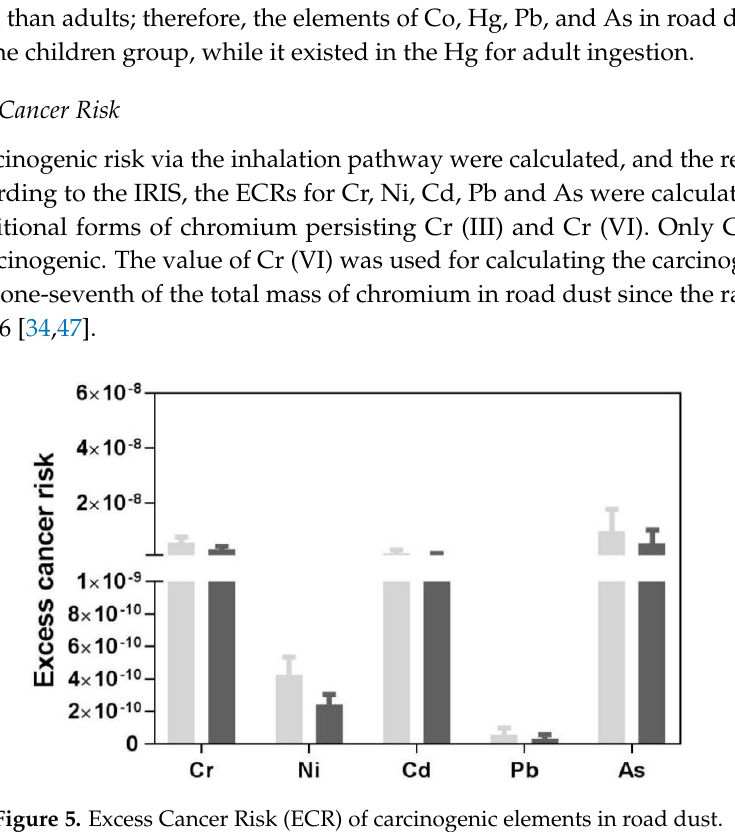
Figure 5. Excess Cancer Risk (ECR) of carcinogenic elements in road dust.